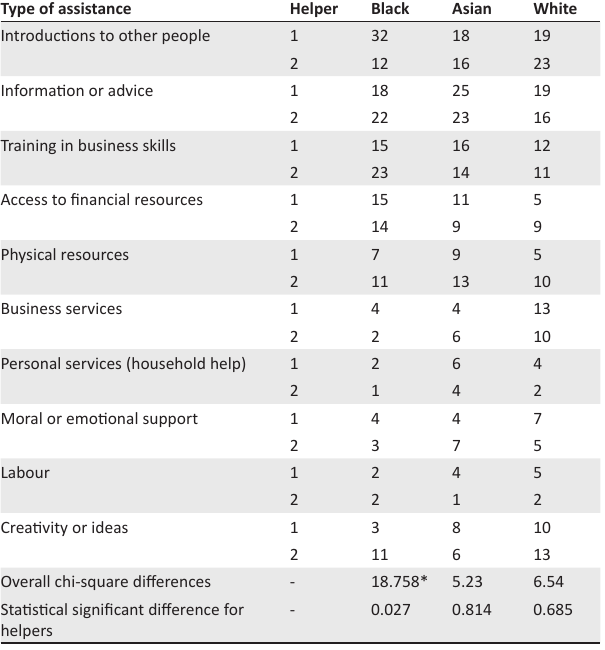
TABLE 2: Types of networking assistance provided, by persentage, by each helper for different ethnic groups. Type of assistance